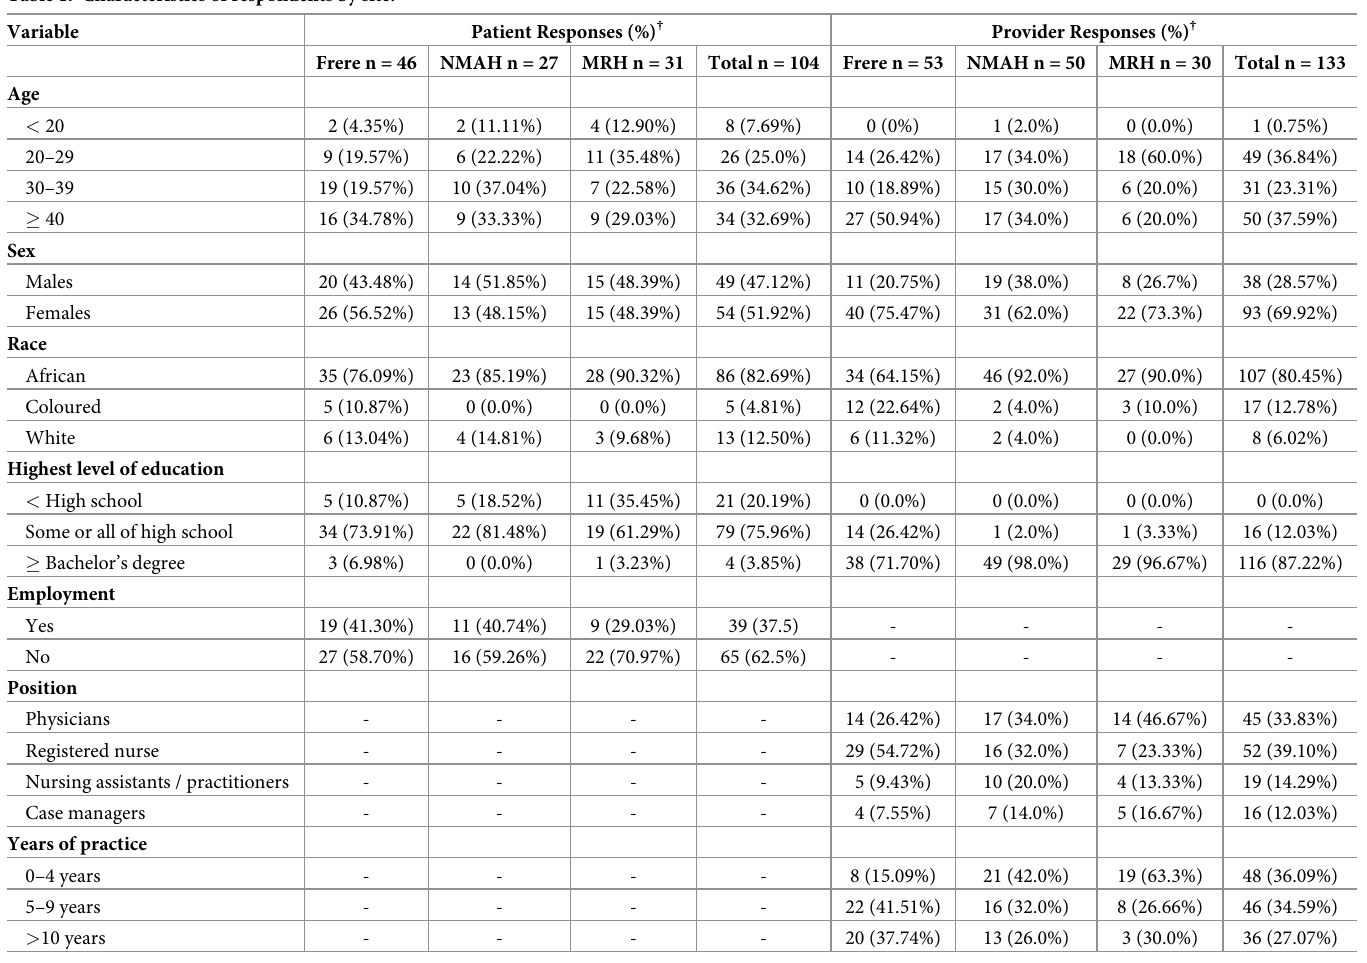
Table 1. Characteristics of respondents by